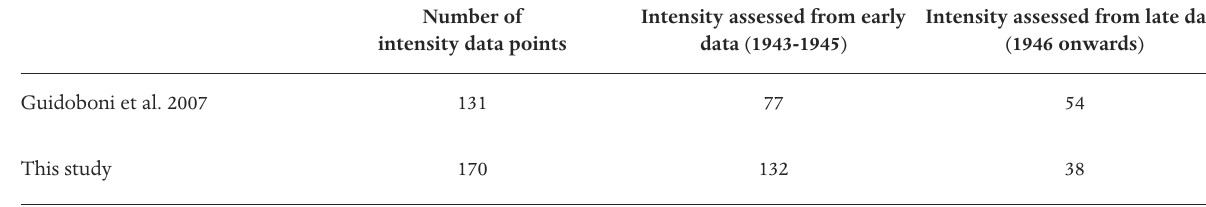
Table 3. Synthesis of the comparison between the state of the art before and after this study.